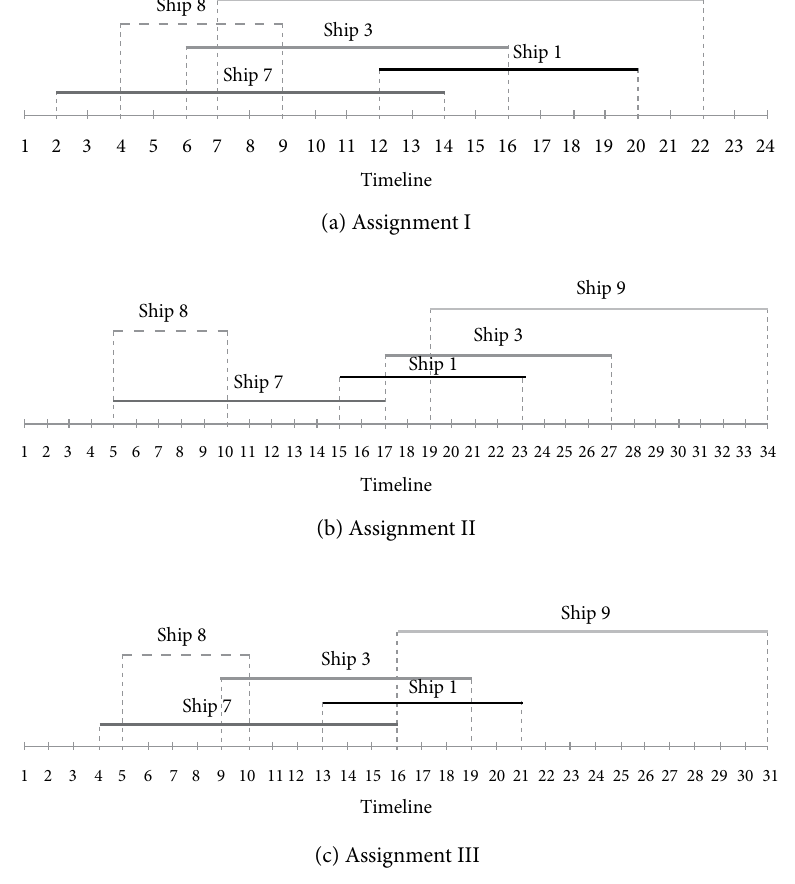
Fig. 2. Overlaps of small ships when ships are assigned at (a) on their arrival times, (b) on their standby limits, and (c) on random times between arrival times and standby limits